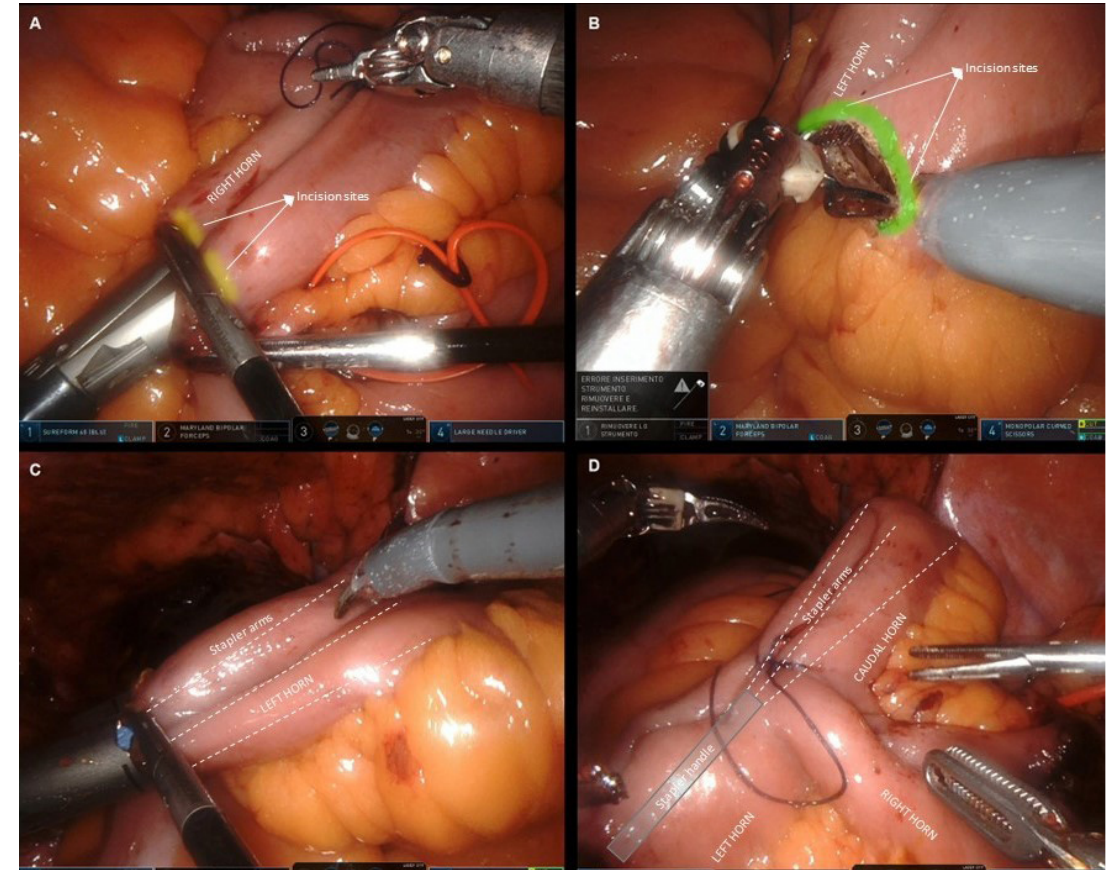
Figure 2. ( A ) Side-to-side anastomosis of the right horn. ( B ) Incision of the left horn. ( C ) Introduction of the stapler through the incision and anastomosis, producing a detubularized horn. ( D ) Through the same incision, the stapler is pushed toward the caudal horn to complete the detubularization of the intestinal tract utilized for the neobladder.